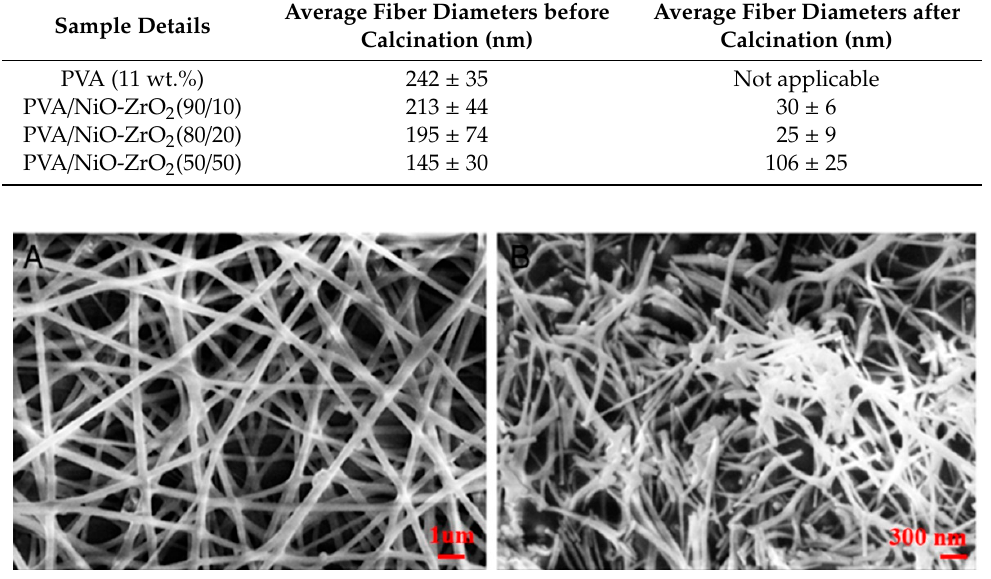
Figure 4. The SEM image (10% load) of the PNZ: as-spun fiber ( A ); and the calcined fiber ( B ). Reproduced [60] with permission from Elsevier, 2014.